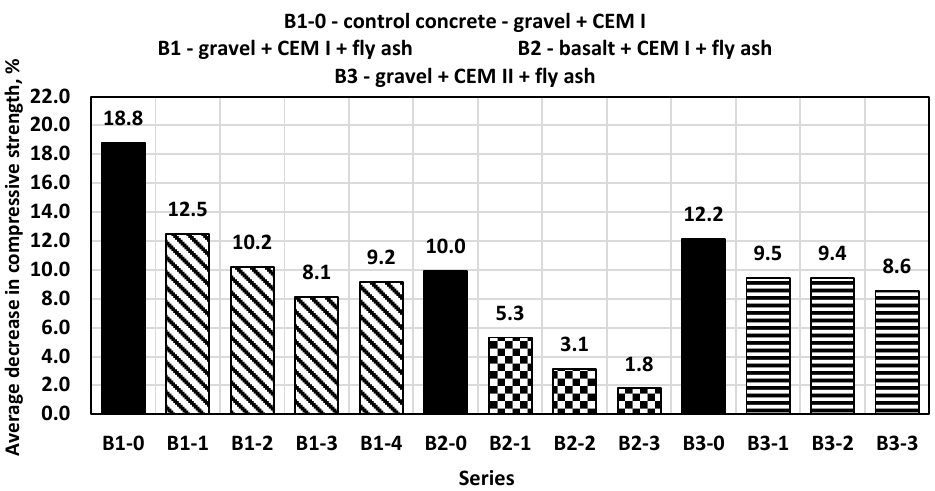
Figure 7. Decrease in the average compressive strength after frost resistance tests.